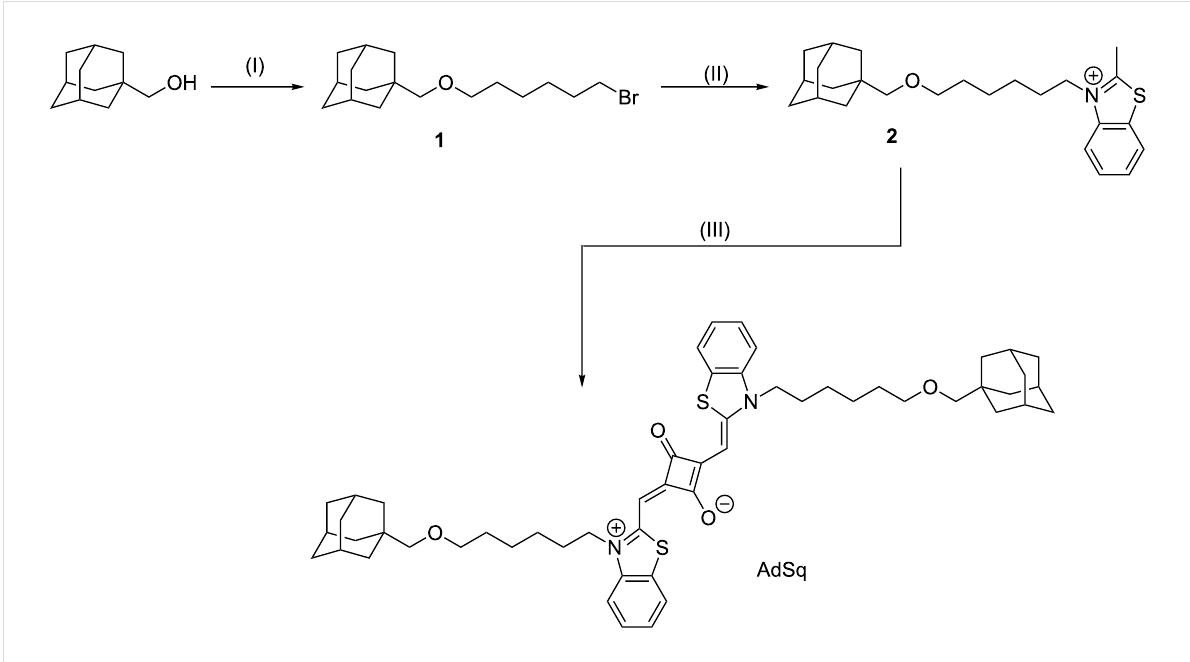
Figure 6: Synthesis of AdSq (I) NaH, DMF, 1,6-dibromohexane, 24 h, rt. (II) benzothiazole, acetonitrile, 12 h, 90 °C, 5%; (III) squaric acid, benzene, n -butanol, pyridine, 12 h, 120 °C, 26%.